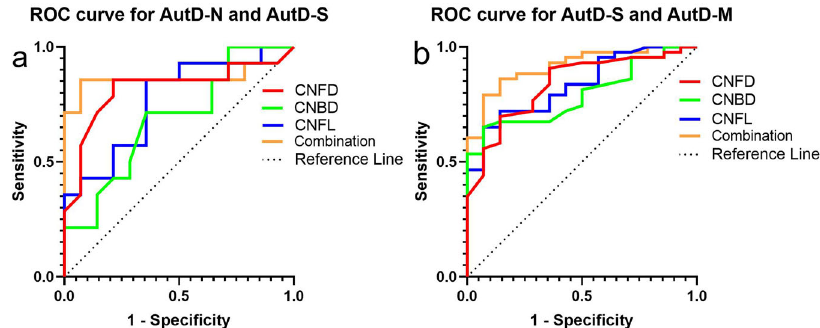
Fig. 5 The ROC for CCM to distinguish AutD-N from AutD-S and AutD-S from AutD-M. a , b PD Parkinson ’ s disease, AutD-N patients with no autonomic symptoms, AutD-S patients with single-domain autonomic symptoms, AutD-M patients with multiple-domain autonomic symptoms, CNFD corneal nerve fi ber density, CNBD corneal nerve branch density, CNFL corneal nerve fi ber length, AUC area under the